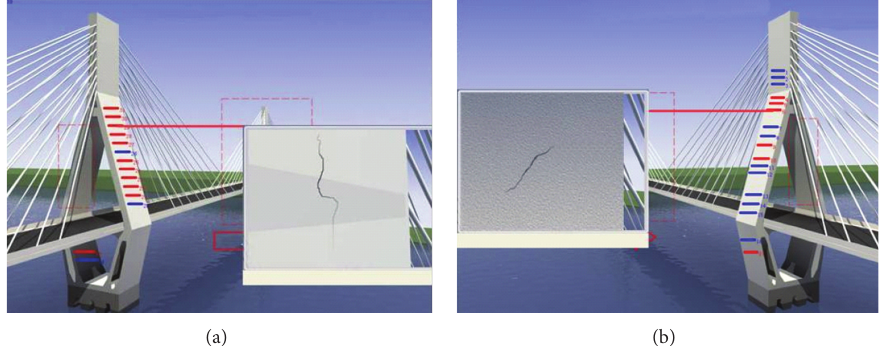
Figure 13: Visual recurrence of the real crack: (a) 29th smart film of tower no. 1 and (b) 31st smart film of tower no.